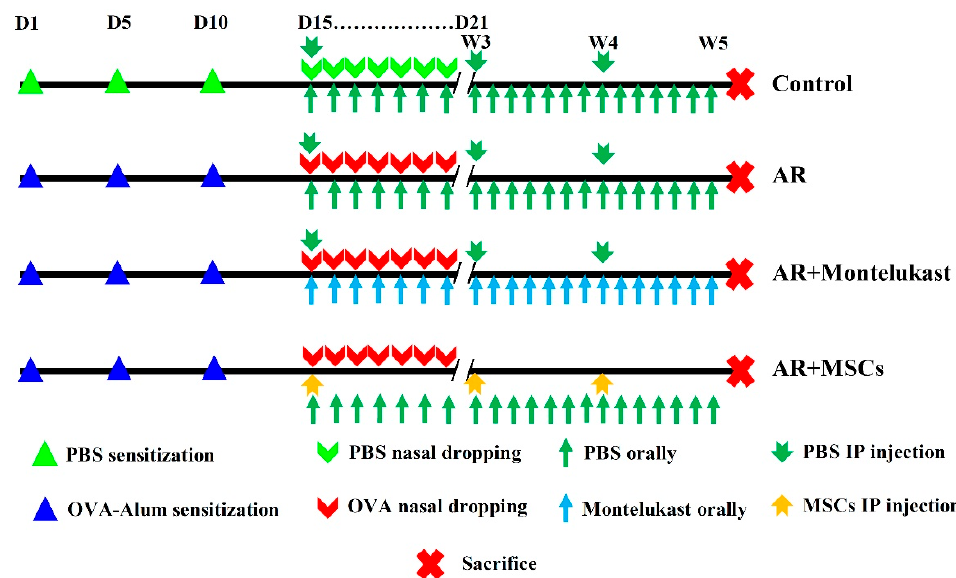
Figure 8. Experimental design and treatment procedure. The rats were divided into four groups: Group I (control group; n = 15 subdivided into 3 subgroups [5 rats each]), Group II (AR group; n = 6), Group III (AR + Montelukast; n = 6), and Group IV (AR + MSCs; n = 6). The rats of the AR groups were sensitized by OVA and then challenged with daily nasal drops of OVA diluted in sterile physiological saline (50 µ L/nostril, 100 mg/mL, 10% OVA) from days 15 to 21 with/without treatment by Montelukast (1 h before each challenge) or MSCs I/P injection (1 × 10 6 MCSs; weekly for 3 constitutive weeks). Both Montelukast and MSCs treatment started from day 15 of the experiment. At the end of the 5th week, blood samples were collected from all rats for immunological assays and histological and molecular biology examinations.